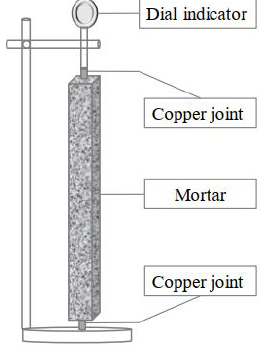
Figure 1. Example of the comparator.